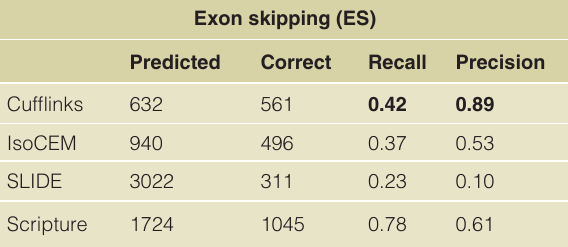
Table S2. Performance of four transcript assembly programs in capturing exon skipping events from simulated